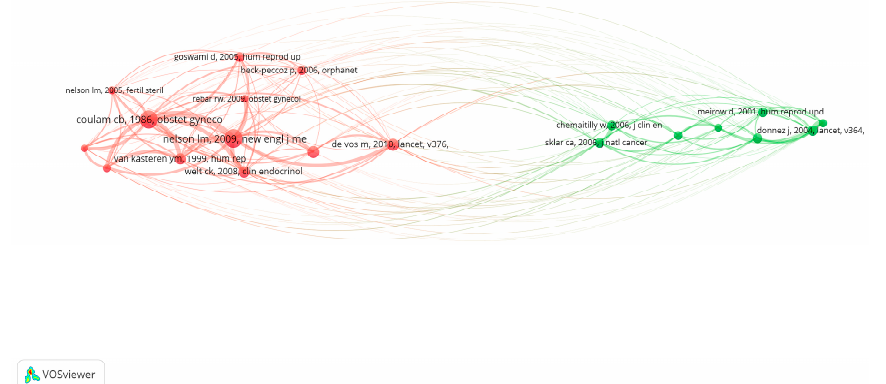
Figure 8. Co-citation analysis of references. The size of the node indicates the record of documents